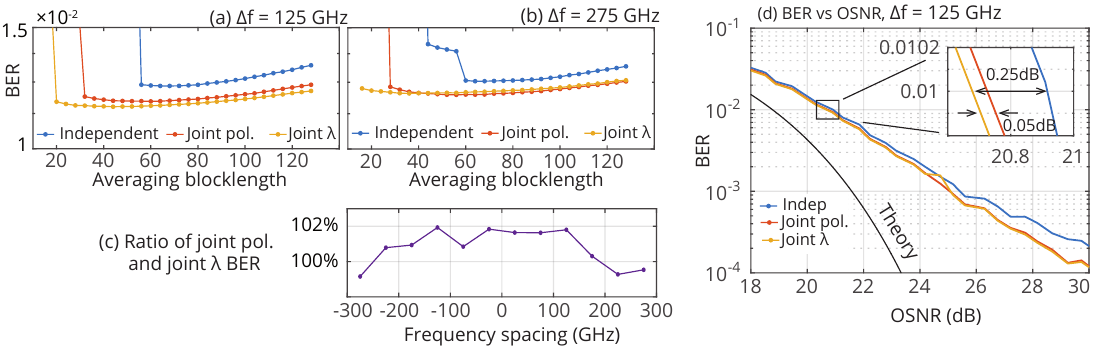
Figure 9. ( a , b ) Bit-error rate (BER) of the center channel as a function of the filter block-length, with either independent, joint-polarization or joint-wavelength phase estimation for different frequency spacings to the other wavelength channel. The optical signal-to-noise ratio (OSNR) is 20.3 dB. ( c ) The ratio between the BER for joint-polarization and joint-wavelength phase estimation as a function of frequency spacing. The optimal block length is used in all cases. OSNR ∼ = 20dB. ( d ) BER vs. OSNR for a frequency spacing of 125GHz. The block lengths are 96, 48 and 32 for independent, joint polarization and joint wavelength, respectively, which are close to the optimum values. The theoretical curve corresponds to an additive white Gaussian-noise channel assuming Gray-coding and only nearest neighbor errors